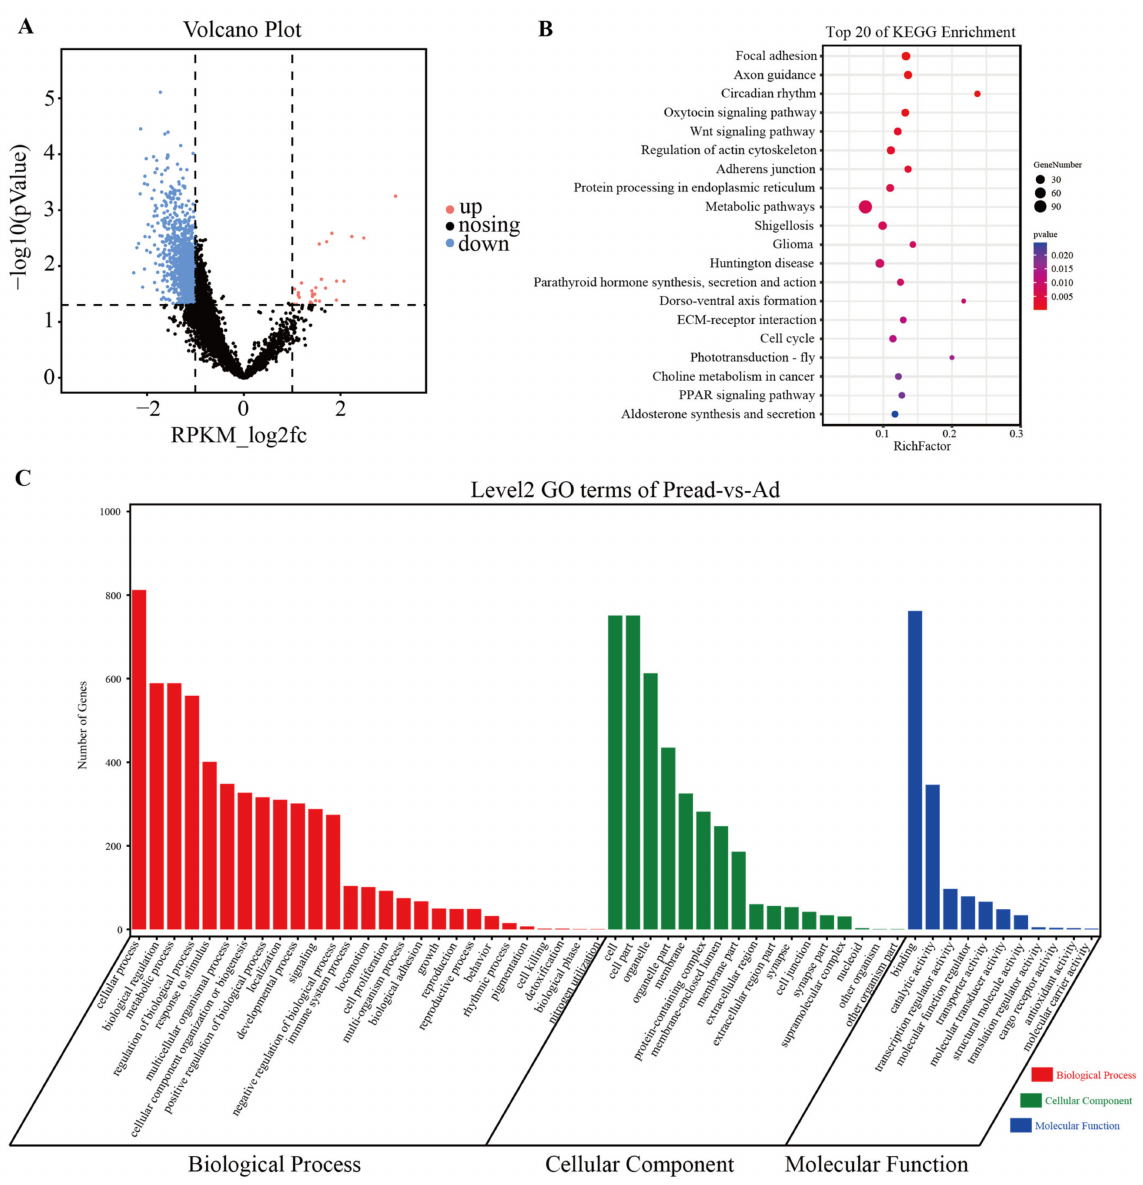
Figure 3. GO and KEGG pathway enrichment analysis of genes associated with differential chromatin accessibility. ( A ) Volcano plots showing differential ATAC peaks (|log2FC| > 1, p -value < 0.05) between Pread and Ad groups. ( B ) The top 20 KEGG pathways for the genes of differential ATAC peaks. ( C ) GO functional annotation of differential chromatin accessibility between Pread and Ad